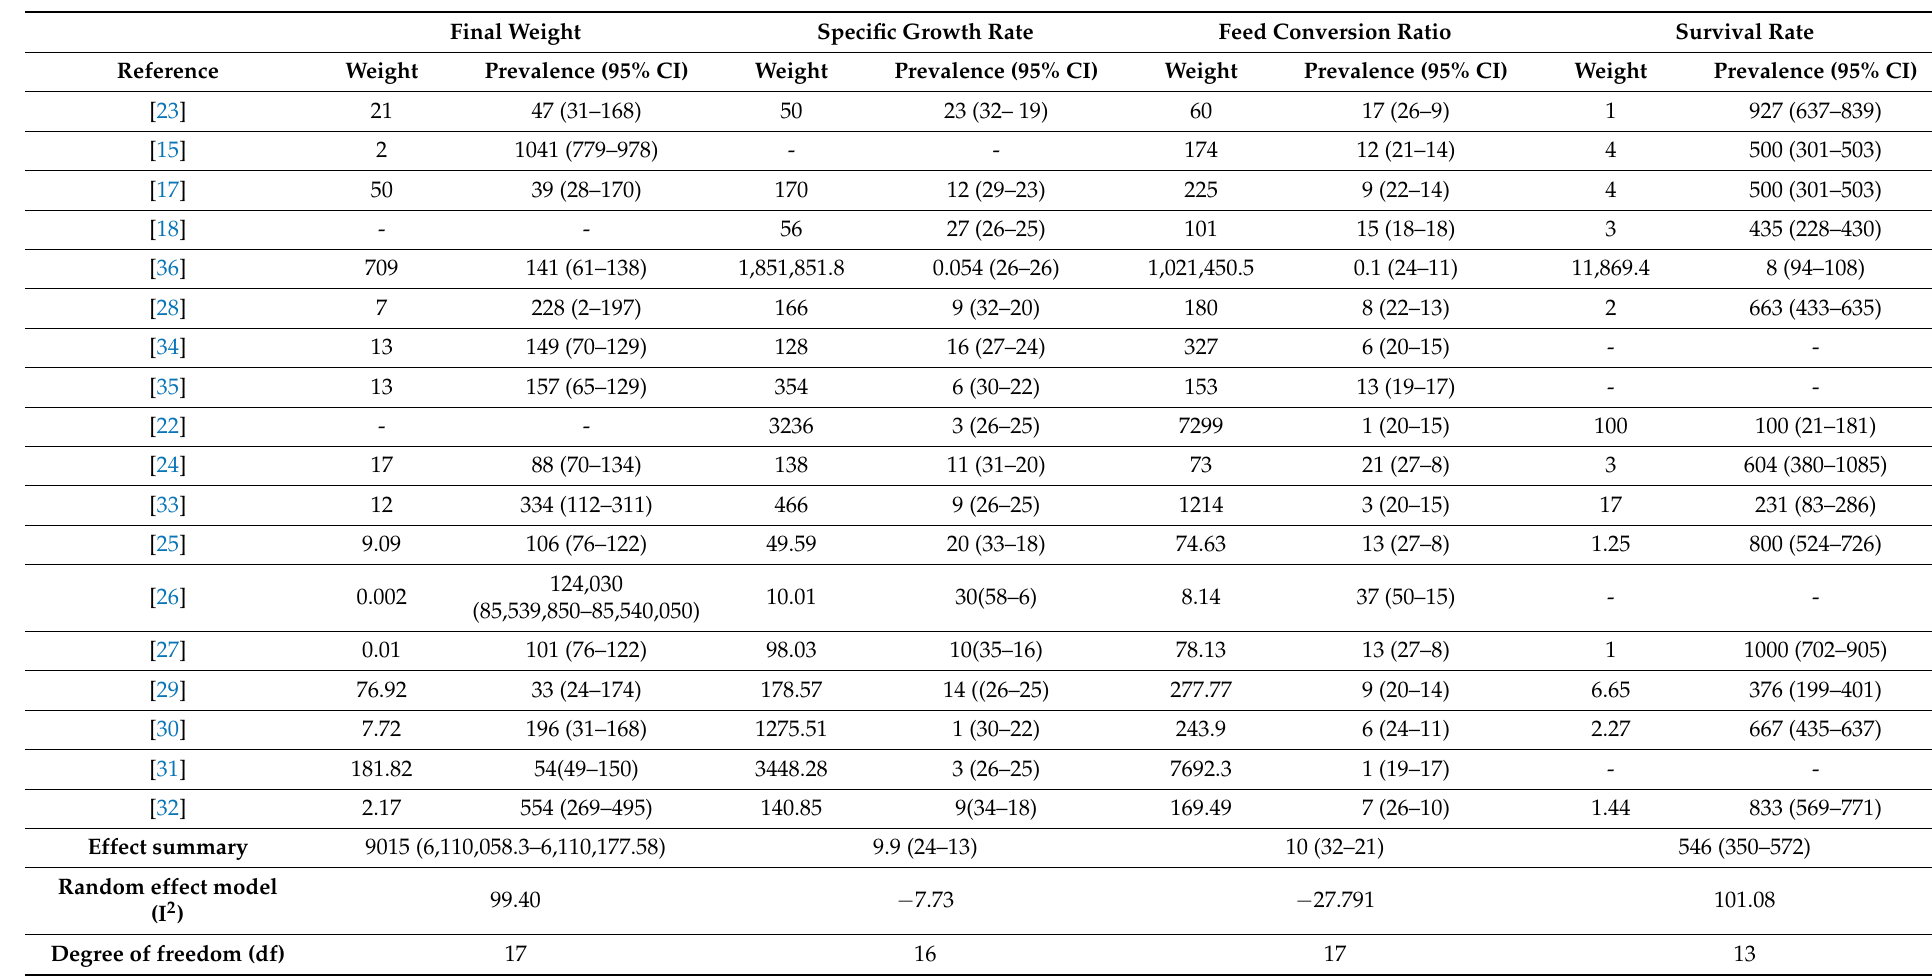
Table 3. Weights, prevalence (95 % CI), effect summary, I 2 index, and degree of freedom for final weight, specific growth rate, feed conversion rate, and survival rate for different studies included in the